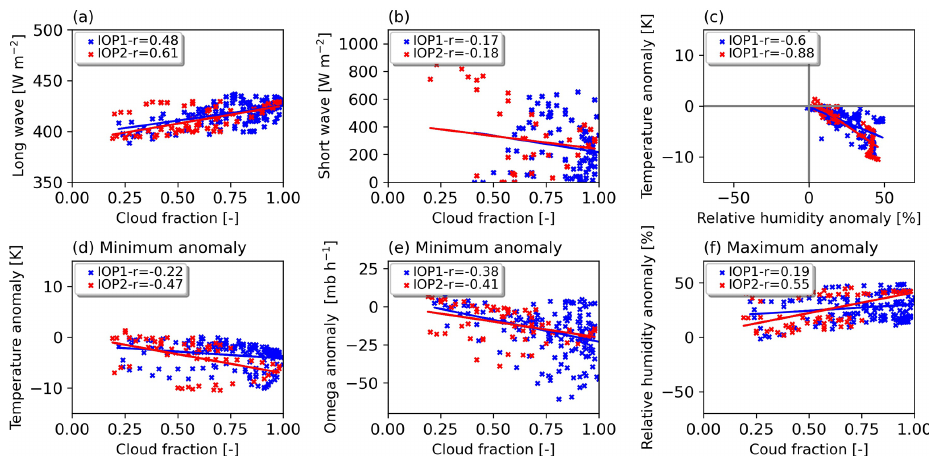
Figure 9. Scatter plots between the cloud fraction simulated with the SAM model and longwave radiation, shortwave radiation, temperature and relative humidity anomalies, minimum values of temperature anomalies, minimum omega anomalies, and maximum relative humidity anomalies for selected cases during IOP1 (wet season – blue markers) and IOP2 (dry season – red markers).